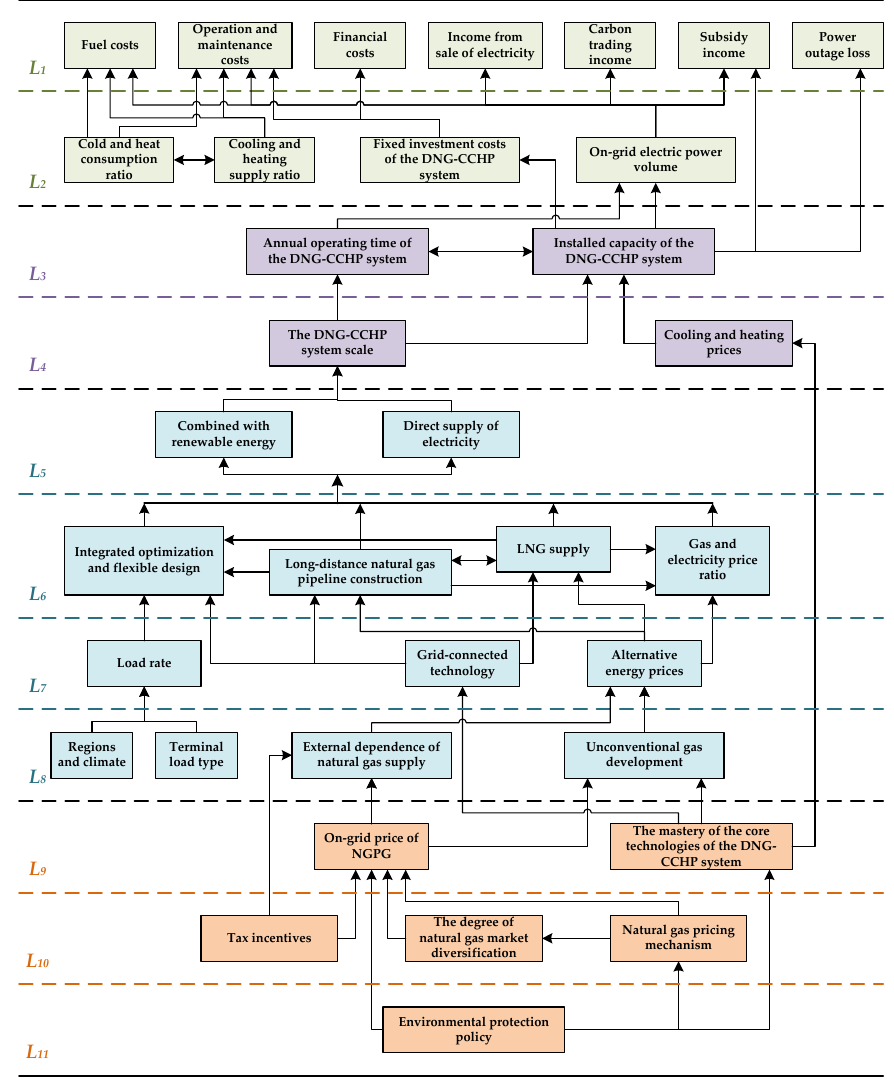
Figure 3. The hierarchical structure graph for the factors affecting the economics of DNG-CCHP systems.